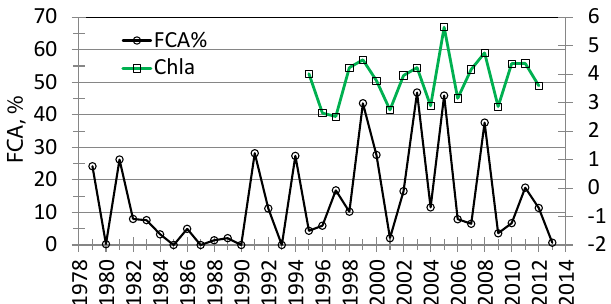
Figure 15. Time series from along Algaline ship transects in the Eastern Gotland basin during July–August: mean extracted chloro- phyll a (mgm − 1 ) at approximately 5m depth (green line, right axis) and the corresponding frequency of cyanobacteria accumulations (black line, left